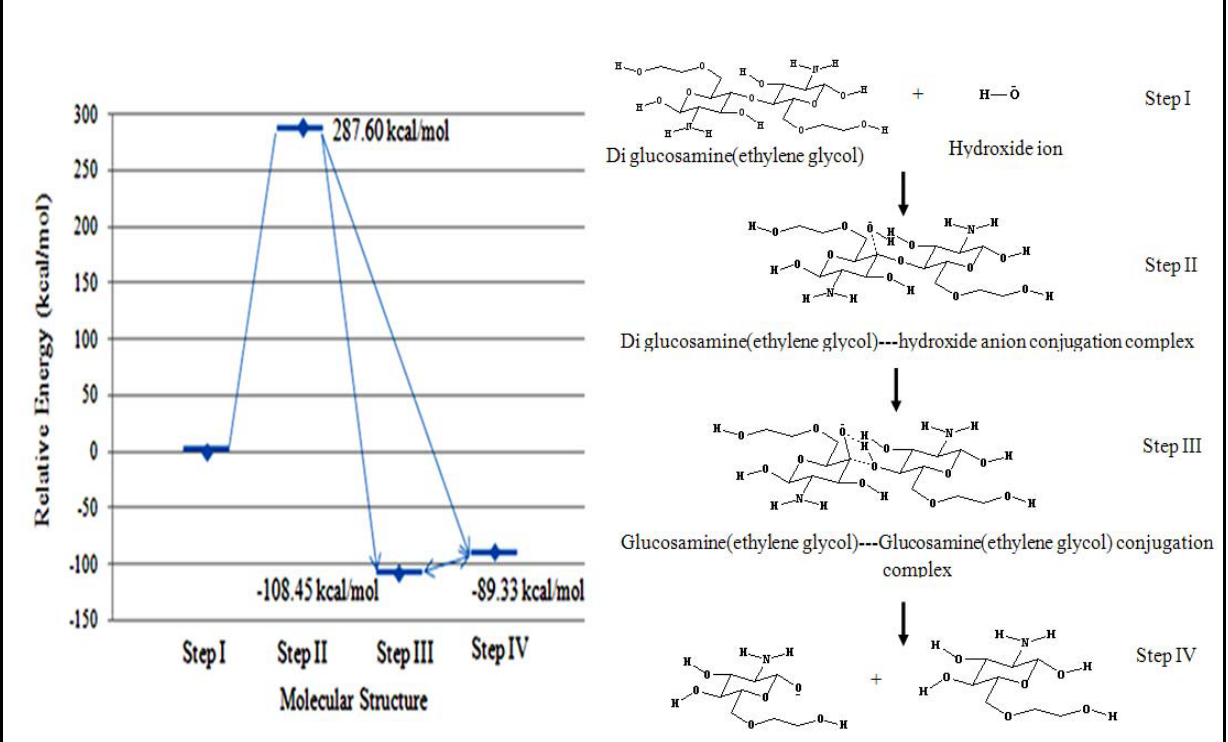
Figure 5. Relative energies of reaction intermediates during the basic hydrolysis of diglucosamine(ethylene glycol) calculated with B3LYP/6-31G//PM3. The reaction mechanism involves the four steps listed